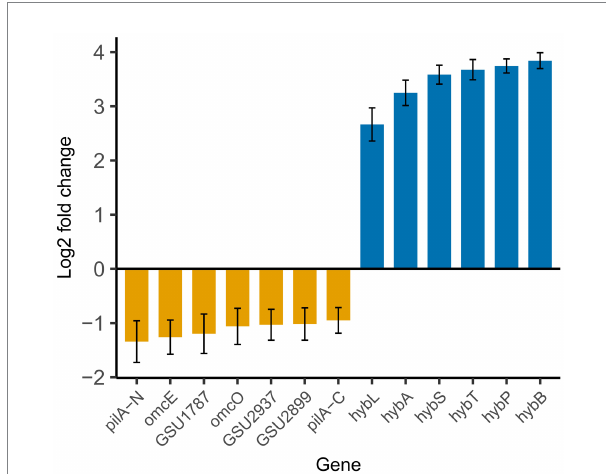
FIGURE 4 pKJK5 downregulates transcription of pilA and several cytochromes in G. sulfurreducens . Gene transcription of G. sulfurreducens with pKJK5 compared to gene transcription of G. sulfurreducens without pKJK5. GSU1787, GSU2937 and GSU2899 encode c-type cytochromes. Error bars show SD ( n = 3). For full table of differentially transcribed genes see Supplementary Table